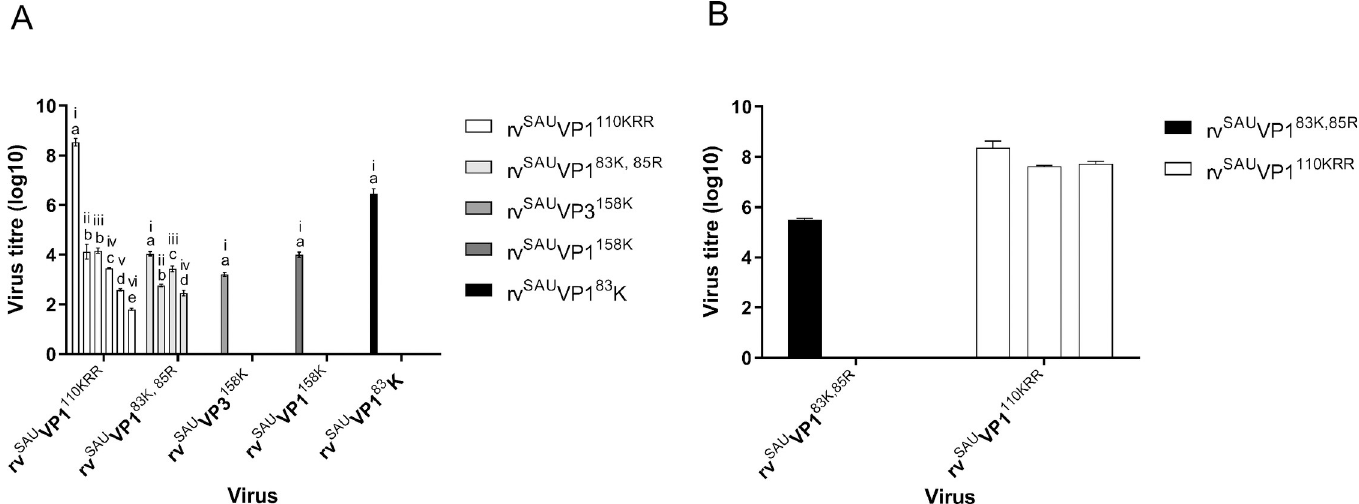
Fig 4. Infection of CHO-K1 cells by the recombinant mutants rv SAU VP3 158K , rv SAU VP1 83K and rv SAU VP1 158K is inhibited by heparin. ( A ) Viruses with titres ranging from 5 × 10 7 to 7 × 10 7 PFU/ml were mock-treated or treated with different concentrations of soluble heparin, where i, ii, iii, iv, v and vi refers to 0mg/ml, 0.625mg/ml, 1.25mg/ml, 2.5mg/ml, 5mg/ml and 10mg/ml heparin respectively, before infecting CHO-K1 cell monolayers. Each treatment was performed in triplicate. Virus that had not been internalized was removed by washing with MES buffer (pH 5.5). The number of plaques formed on CHO-K1 cells was counted and expressed as the percentage of infectivity in relation to the non-heparin treated chimeric viruses. Statistical analyses were performed using a one-way ANOVA (followed by a Bonferroni’s Multiple Comparison test). The confidence interval was 95%. Statistical analyses were carried out using GraphPad Prism v5.0 (GraphPad Software). Error bars represent the standard deviation. The a, b, c, d, or e denotations refer to statistically significant groupings where a is statistically significant to b, c, d and e; b is statistically significant to c, d and e; c is statistically significant to d and e and d is statistically significant to e. (B) Heparinase treatment of BHK-21 cells. BHK-21 cell monolayers were incubated with heparinase I or III enzymes or were mock-treated for 30 min at 37˚C before virus infection (100 PFU/well). The number of plaques were determined at 24 hpi on BHK-21 cells and the percentage reduction in plaques calculated. The data represent means ± SD from three independent experiments.